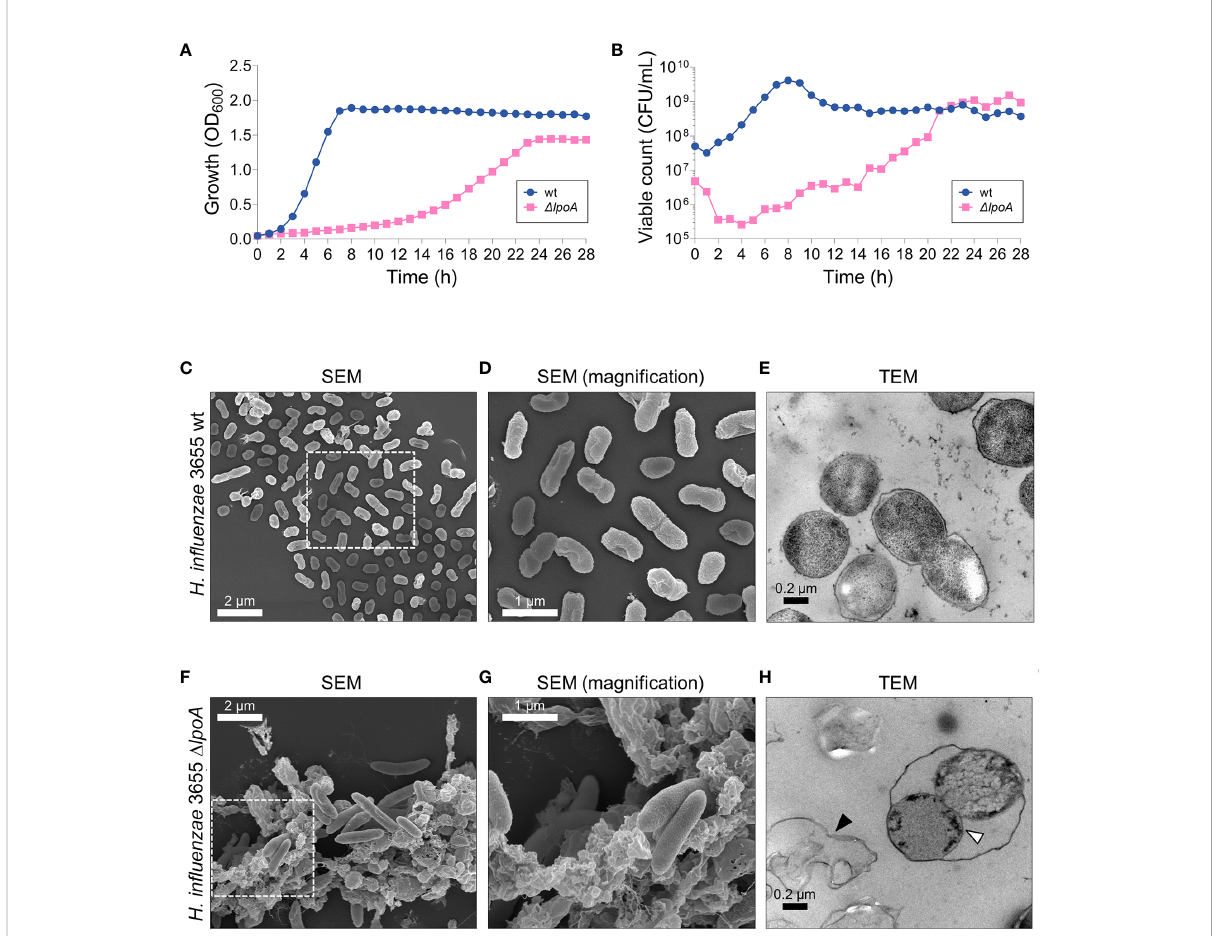
FIGURE 2 The loss of LpoA causes fi tness defects in H. in fl uenzae. (A) Measurements of the growth (culture OD 600 ) and (B) viable count (CFU/ml) of H. in fl uenzae 3655 wt and the D lpoA isogenic mutant revealed a dramatic loss of fi tness associated with LpoA-de fi ciency. A representative experiment out of two is shown. (C – H) Electron microscopy images showing the morphological differences between wt (C – E) and the isogenic mutant D lpoA (F – H) . Scanning EM shows excessive cellular debris in the LpoA-de fi cient strain (F) compared to wt cells (C) . (D, G) Magni fi cations of the squared areas in (C, F) highlight the morphological differences between wt bacteria and the isogenic mutant. The phenotype is also observed in the TEM images with excessive cell debris prominently present around D lpoA cells ( H ; black arrow) but not the wt. Transmission EM also shows the OM detaching from dividing LpoA-de fi cient cells (white arrow). In (C) a representative area out of 6 is shown. In (D) a magni fi ed area from (C) out of 8 areas with overview is shown. In (F) a representative area out of 5 is shown. In (G) a magni fi ed area from (F) out of 9 areas with overview is shown. In (E) a representative area out of 16 examined is shown. In (H) a representative area out of 18 is shown. lpoA mutant (F – H)